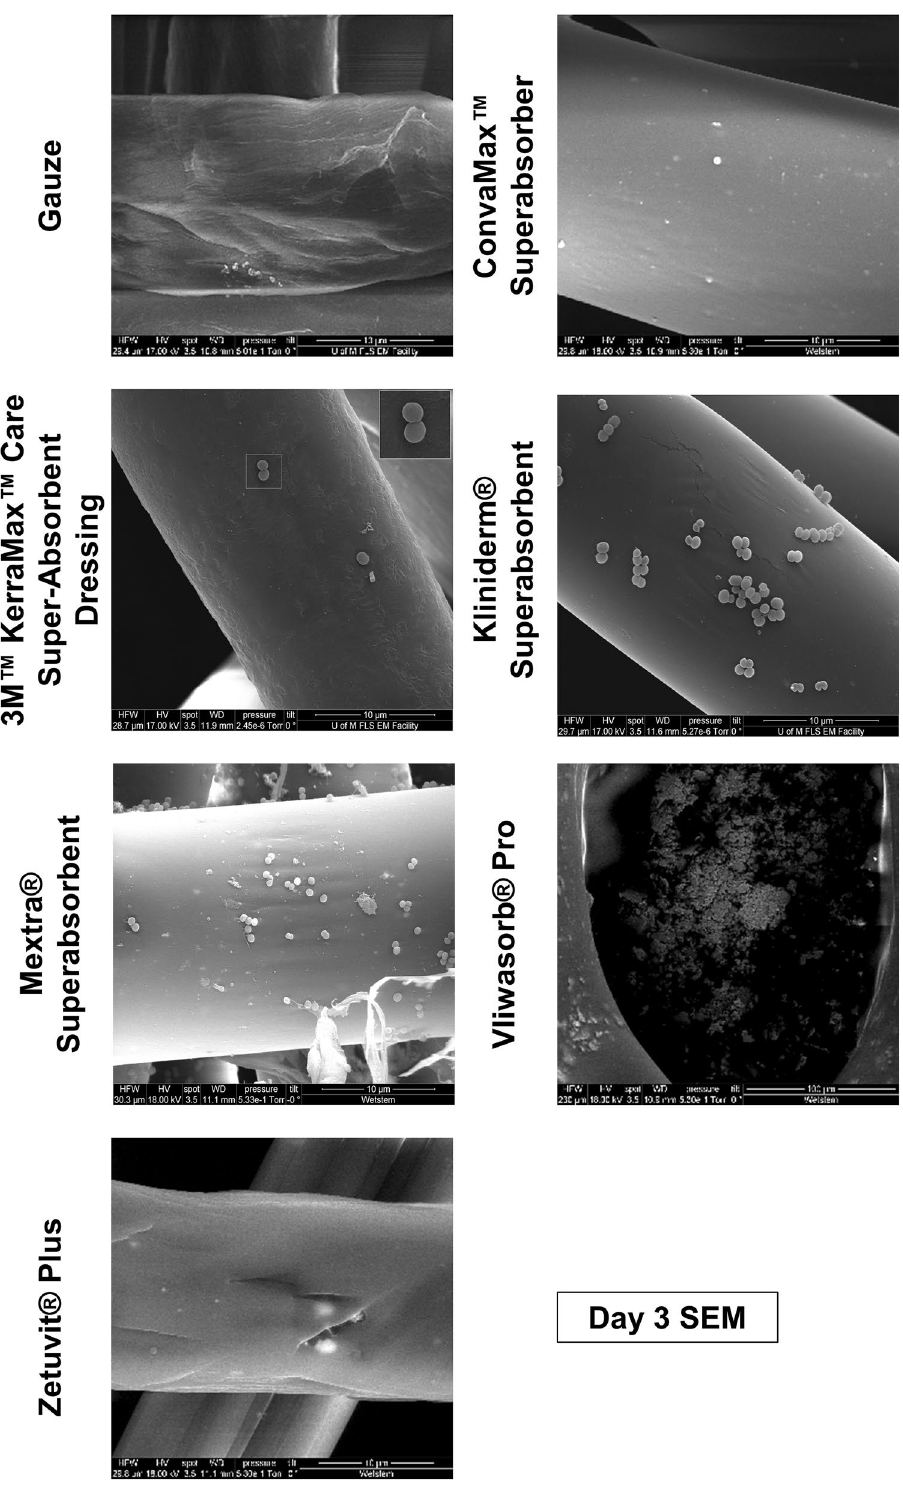
Figure 7. Localisation of S. aureus within the outer layer of superabsorbent dressings at day 3. Superabsorbent wound dressings were inoculated daily with 1 * 10 7 CFU/ml of either Staphylococcus aureus over 7 days in triplicate. On 1, 3 and 7 days of inoculation, the outer membrane of each dressing was removed and fixed in glutaraldehyde, before being critical point dried, painted with conductive silver and sputter coated. Representative images of the outer membrane for dressings inoculated for 3 days with S. aureus are shown. Figure produced in Microsoft PowerPoint